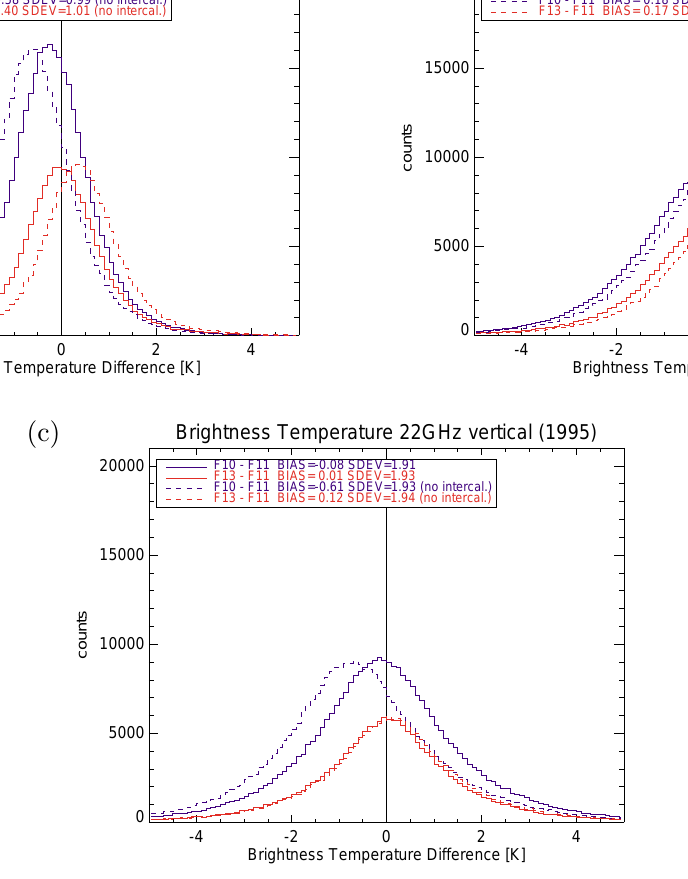
Figure 3. Distribution of 10 day mean TB di ff erences in 0.1K bins for the year 1995 of di ff erent SSM / Is relative to the reference radiometer on DMSP F11. The panels show the comparisons without (dashed lines) and with (solid lines) intercalibration for TB 19v (a) , TB 19h (b) , and TB 22v (c)